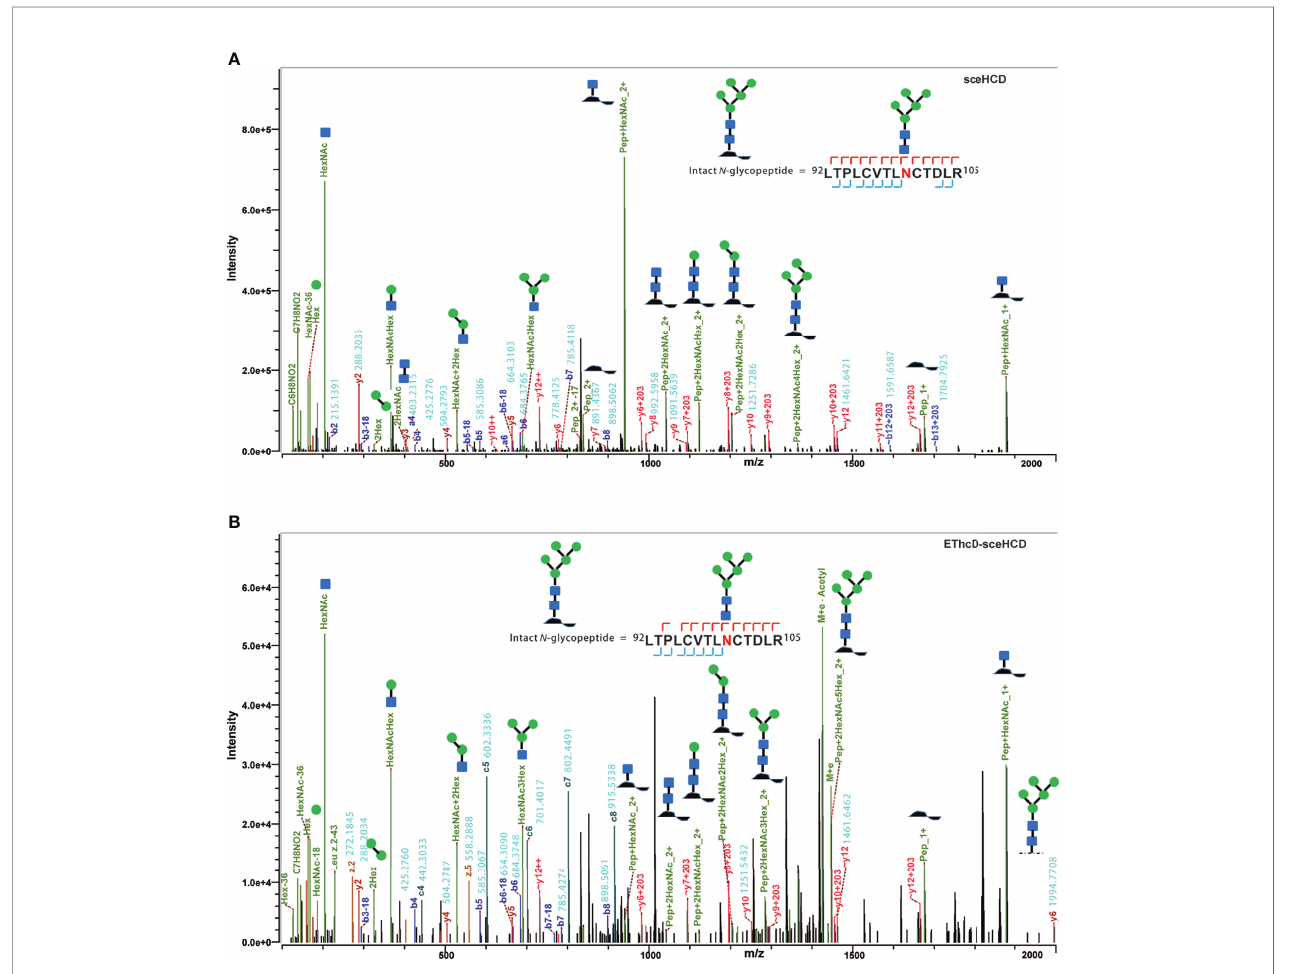
FIGURE 2 | Representative sceHCD-MS/MS (A) and EThcd-sceHCD-MS/MS (B) spectra of an intact N-glycopeptide with a high mannose type N-glycan, HexNAc2Hex5, at amino acid position